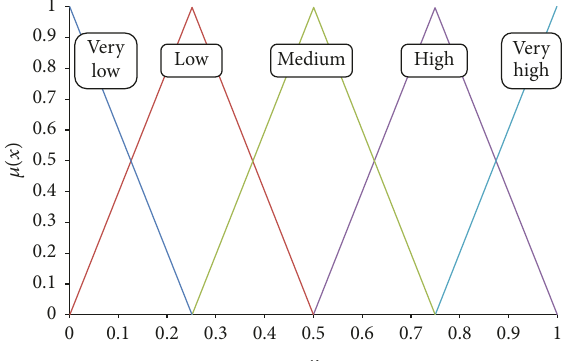
Figure 1: Membership functions for linguistic values in fuzzy